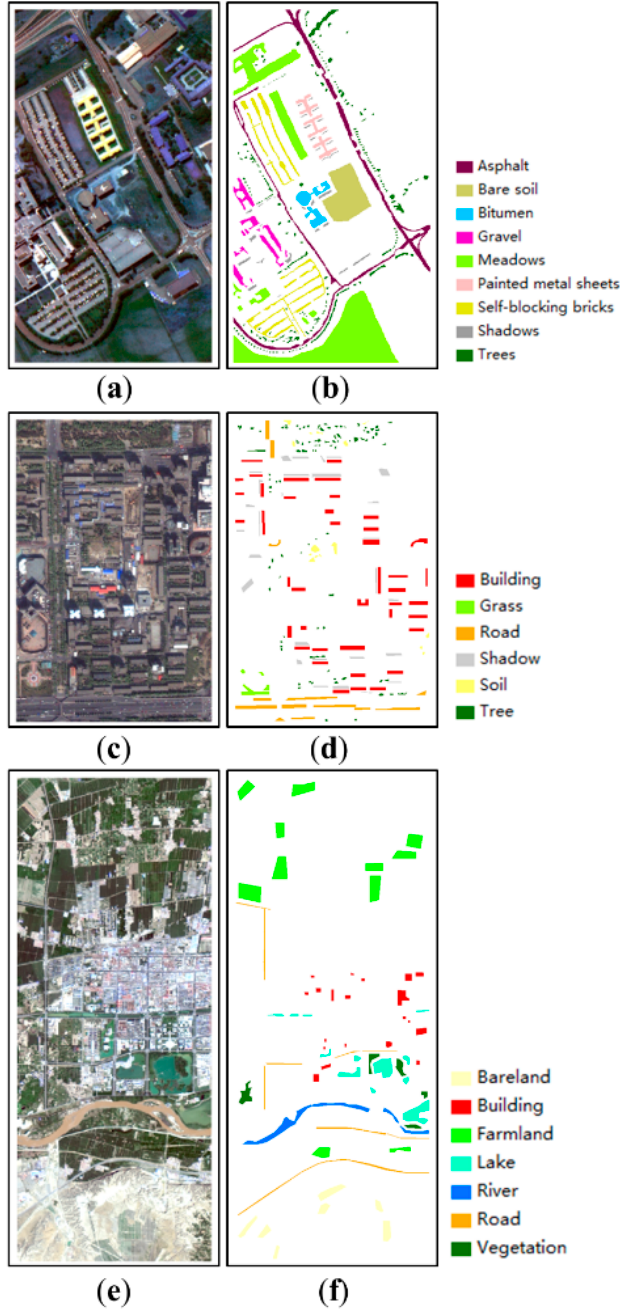
Figure 1. The three images used for experiments: ( a , b ) The ROSIS image subset and the ground-truth map, ( c , d ) the IKONOS image subset and the ground-truth map, ( e , f ) the Landsat image subset and the ground-truth map.